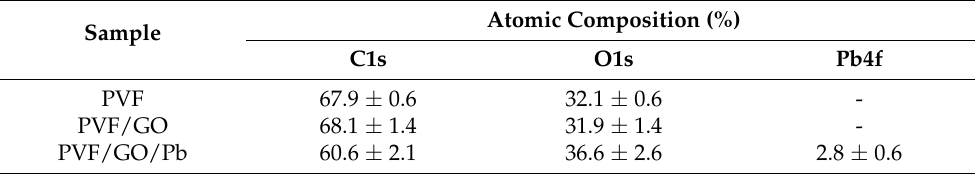
Figure 2. XPS survey scans of PVF/GO and PVF/GO/Pb in comparison to PVF. Table 1. Surface composition of PVF, PVF/GO, and PVF/GO/Pb, as determined by XPS.